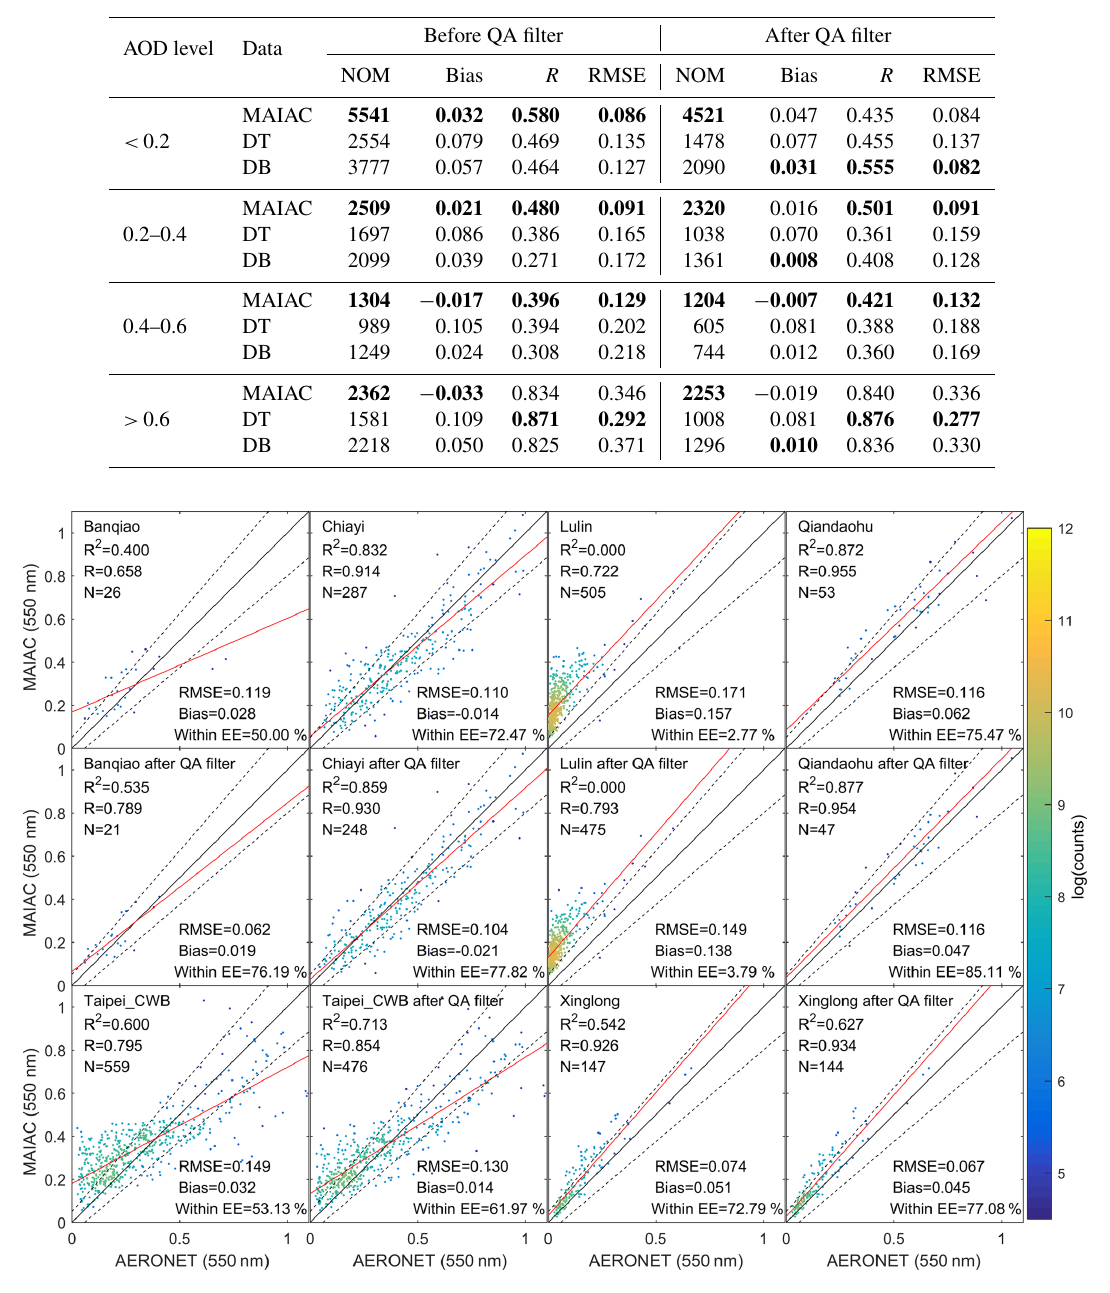
Figure 4. Evaluation of the MAIAC accuracy in the forest area for each AERONET site before and after the QA filter. The black line, red line, and dashed line in the scatterplot are the 1:1 reference line, regression line, and expected error (EE = ± ( 0 . 05 + 0 . 15 × AOD ) ) line,